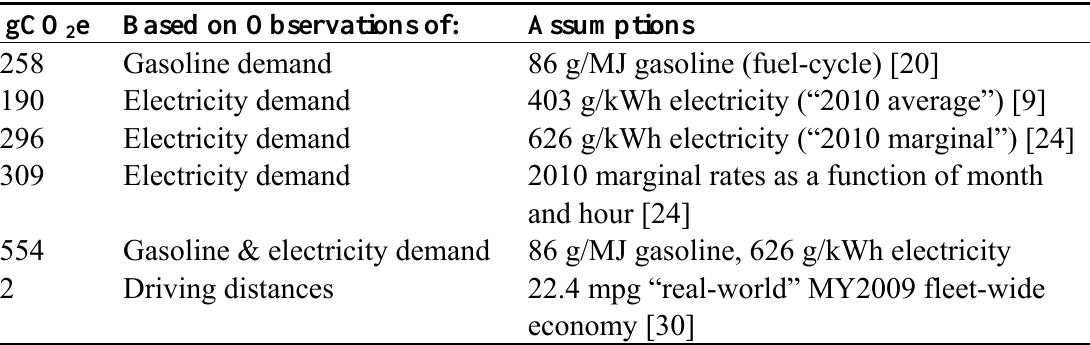
Table 10. GHG emissions